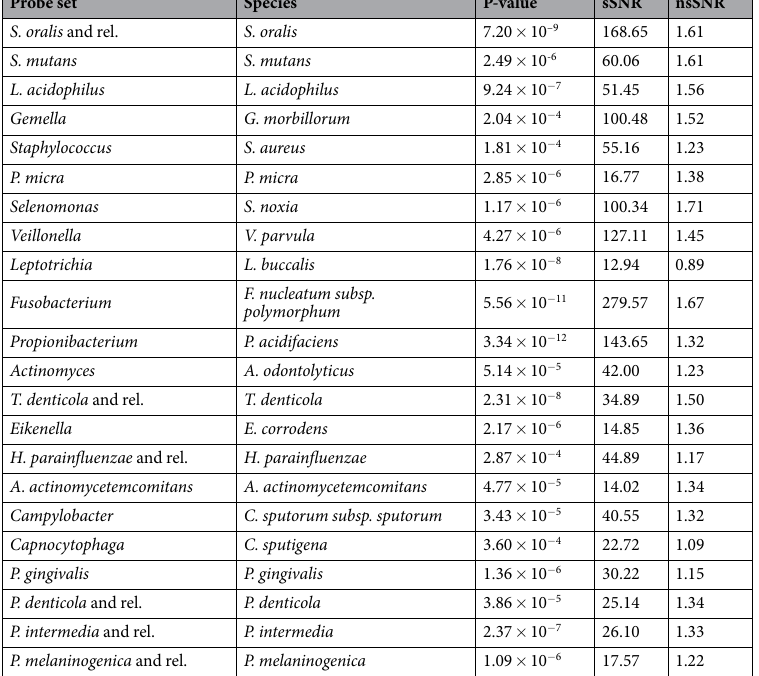
ducibility and sensitivity. The specificity of the designed probe sets was tested by using 10 ng of 16 S rRNA PCR products from twenty-two microorganisms, members of the human oral microbiota (Table 2). Moreover, the probe sets designed for HTF-MicroBi.Array 25 and the VaginArray 26 (already validated towards gastrointesti- nal and vaginal microorganisms, respectively) were subjected to specificity tests by using oral microbial species. Amplicons were prepared by PCR of genomic DNA provided by DSMZ or extracted from pure cultures. All 16 S rRNA amplicons were properly recognized in separate LDR hybridization reactions with the entire probe panel of the array: only probes associated with the expected species and control spots were significantly over the back- ground, with P-values < 0.0005. Signal-to-noise ratios (SNR) calculated for the spots called as significant (sSNR) varied from 12.94 to 279.57, with an average of 64.96, whereas SNR of the remaining spots (not significant spots, nsSNR) varied from 0.89 to 1.71, with an average of 1.36 (Table 2).